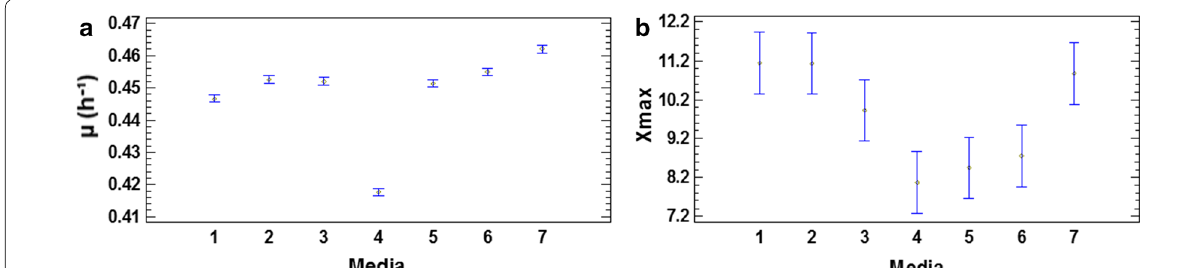
Fig. 2 Influence of mineral salts and vitamins on P. indica H32 growth. a Values of µ obtained with the tested media. b Values of Xmax obtained with the tested media. 1 : medium 1 (7.73 g/L sucrose, 7.07 g/L yeast extract and 100 mL/L phosphate buffer). 2 : medium 1 1 MgSO 4 . 4 : medium 1 NaCl. 5 : medium 1 trace salts solution. 6 : medium 1 + + + solution vitamins. All bars represent the mean values 95.0 percent LSD + ±